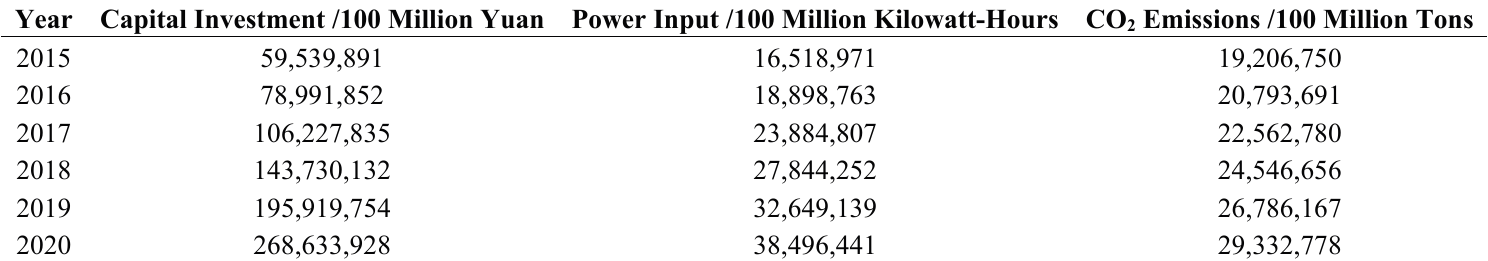
Table 18. Predicted values of the capital investment, power input and CO 2 emissions.